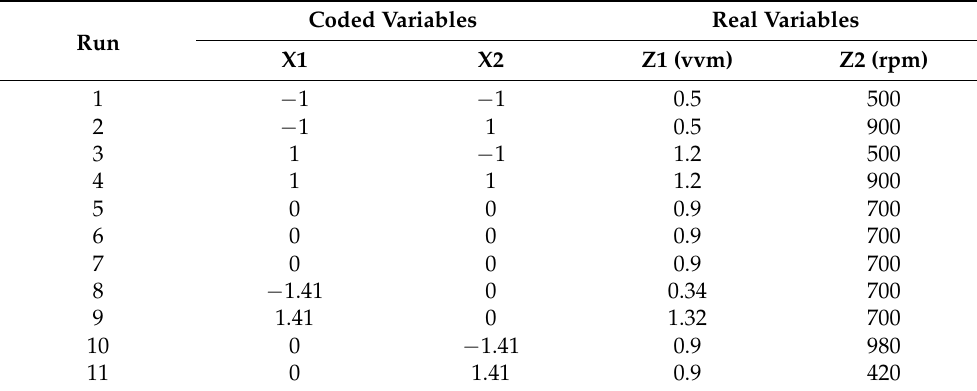
Table 1. Coded and real variables of the 2 k central composite design (CCD). Factors are aeration (vvm) and agitation (rpm). The factors levels were 0.5 vvm, 0.9 vvm, and 1.2 vvm for aeration, 500 rpm, 700 rpm, and 900 rpm for agitation. All runs were performed at 37 ◦ C and pH 9.